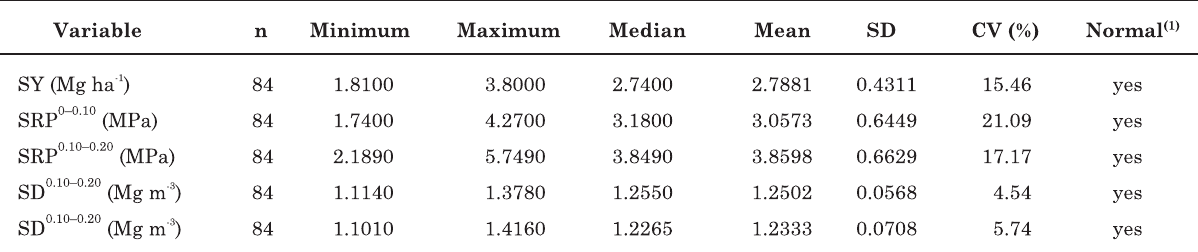
Table 1. Descriptive statistical analysis of the variables: soybean yield (SY), soil penetration resistance (SRP) and soil bulk density